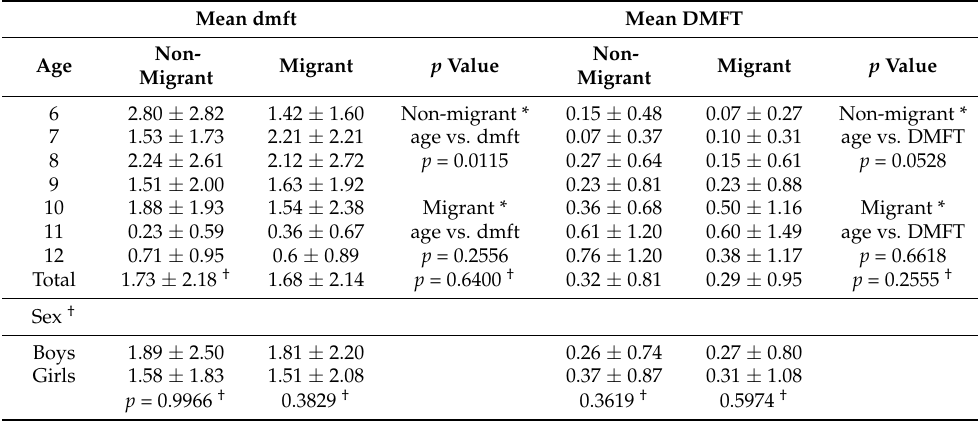
Table 3. Caries experience in primary and permanent teeth by age group and sex in the migrant and non-migrant groups. Mean dmft Mean DMFT Non- Migrant p Value Migrant